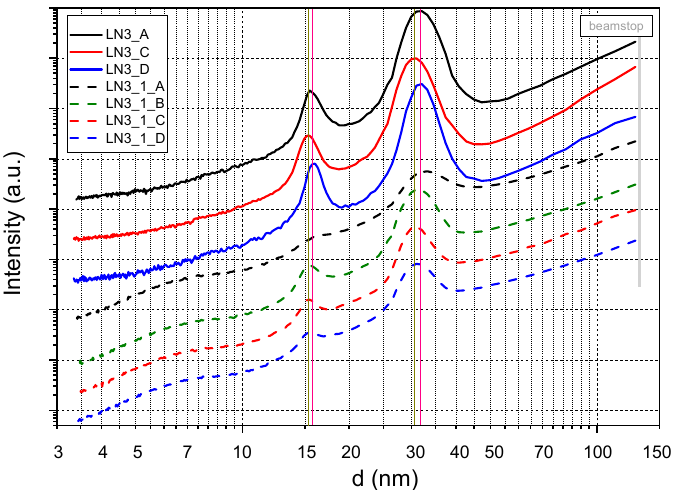
Figure 8. Radial scattering curves of pure LN3 and LN3 composites with 1 wt% MWCNT at processing conditions A (180 °C, 100 rpm), B (180 °C, 200 rpm), C (200 °C, 100 rpm) and D (200 °C, 200 rpm). The scattering curves were calculated from the related 2D-SAXS patterns by azimuthal integration within a small sector Δϕ = ±5° relative to the maxima direction of azimuthal intensity distribution .